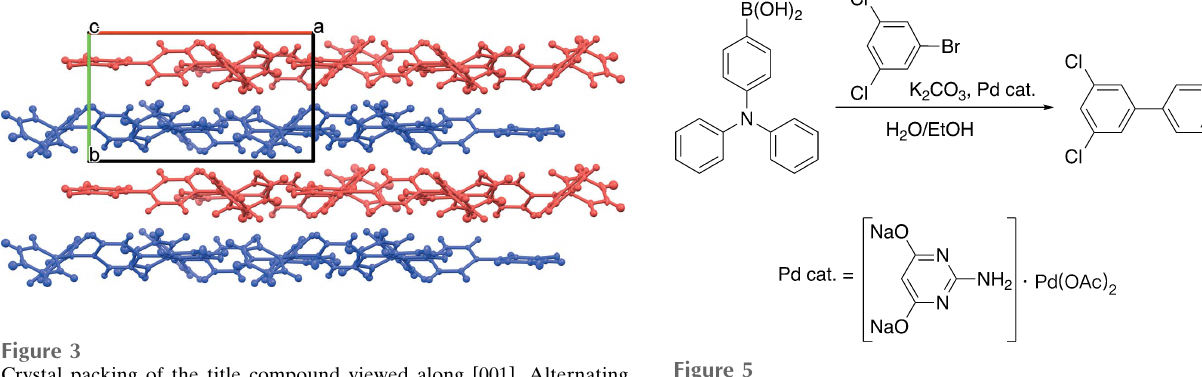
Figure 5 Synthetic scheme for the preparation of the title